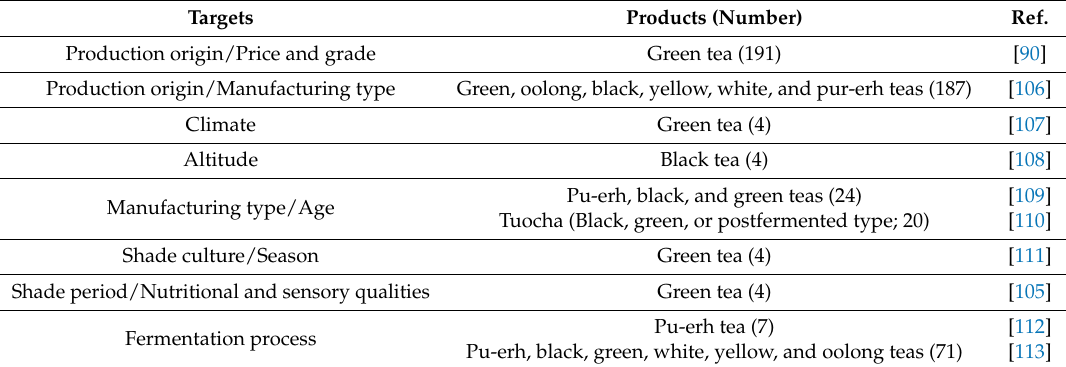
Table 2. Metabolic profiling of tea extracts for quality